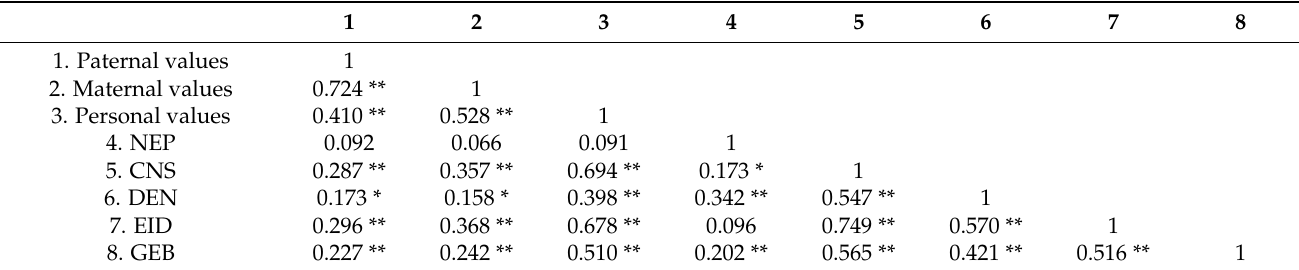
Table 3. Correlation analysis: ecological values, NEP, CNS, DEN, EID, and GEB.